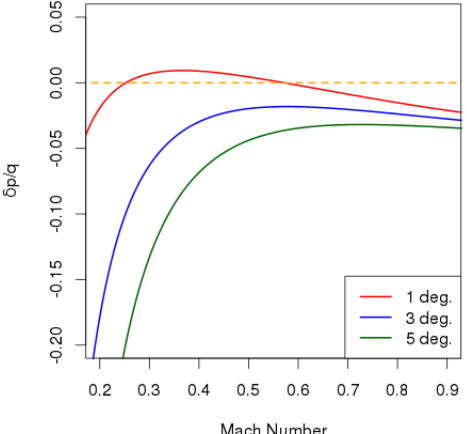
Figure 5. The correction to pressure ( δp ) normalized by the magni- tude of the dynamic pressure ( q ), as a function of Mach number, for three values of the angle of attack. The values plotted are those for the GV as given by Eq. (9) for flight at 500hPa. The format of the plot is chosen to match conventional presentations in aeronautical publications such as Gracey